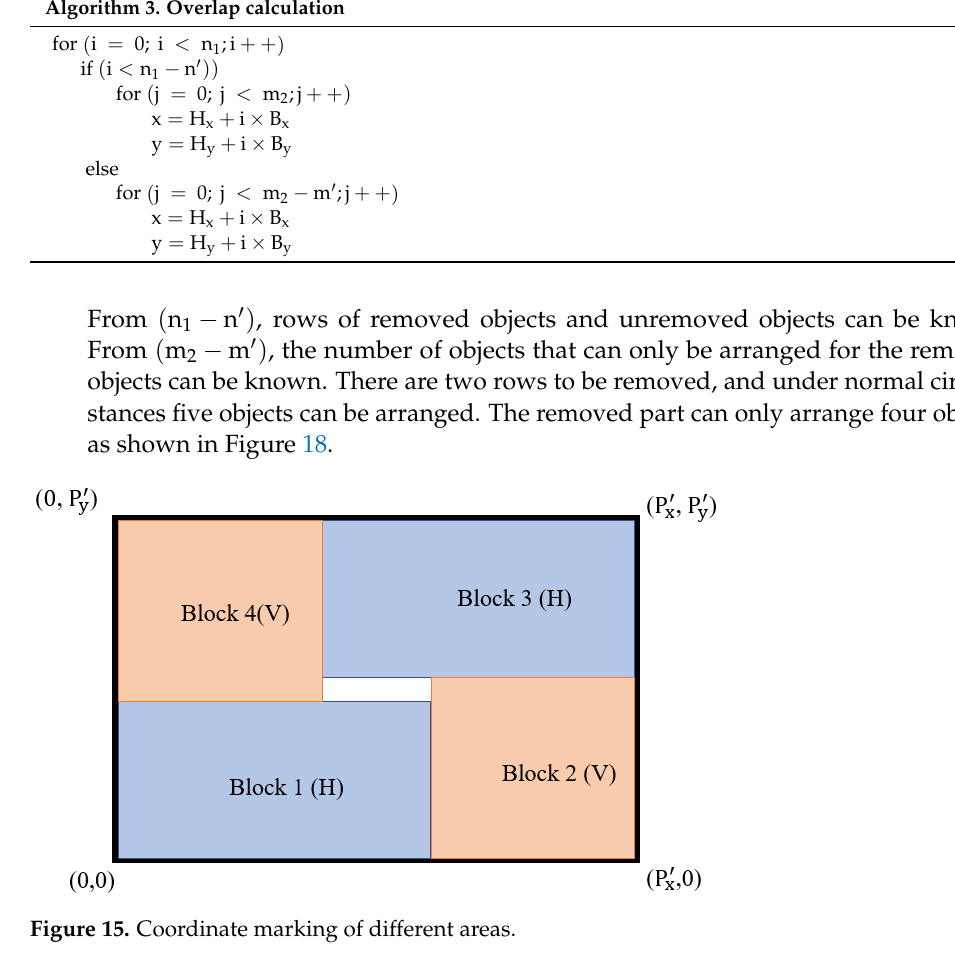
Figure 15. Coordinate marking of different areas.